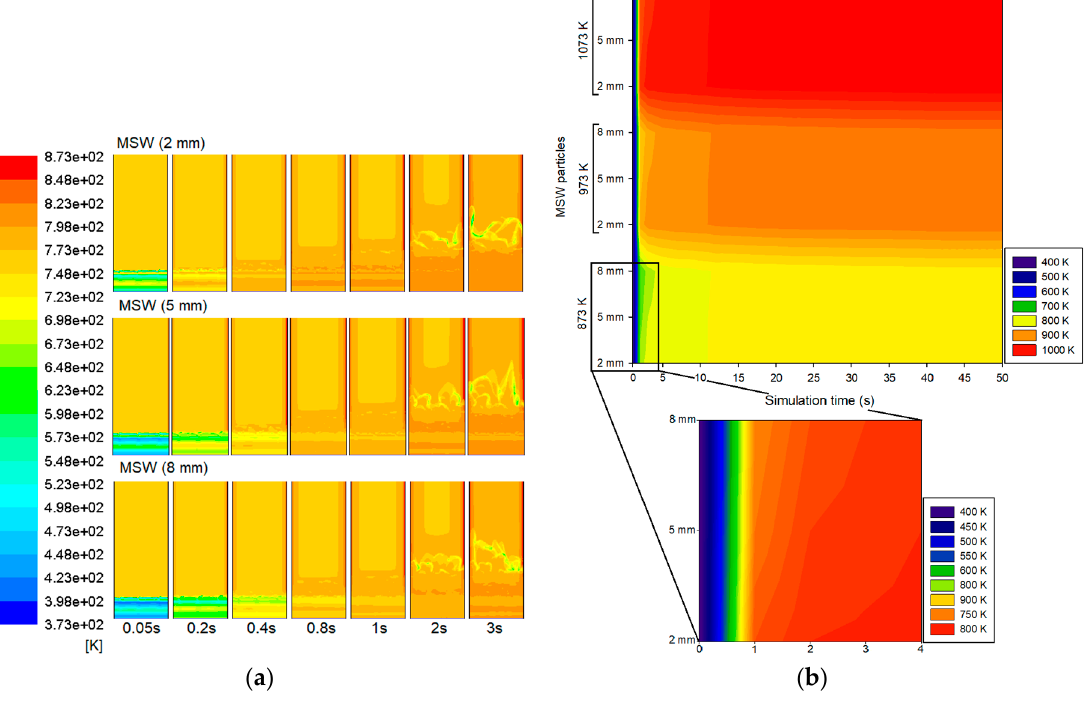
Figure 11. Heat transference performance: ( a ) static temperature contours of the three MSW particles sizes, during a 3 s simulation time and operating temperature of 873 K; ( b ) MSW particles static temperature variation at 873, 973 and 1073 K, along the total simulation time of 50 s.